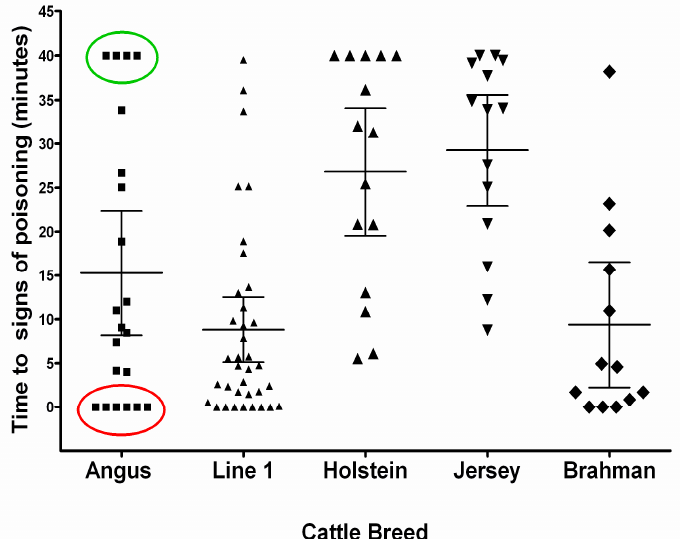
Figure 5. A comparison of different breeds of cattle to larkspur toxicosis. Data represent a scatter plot with the mean and 95% confidence interval for each breed. The data depict the cattle responses to a standardized dose of tall larkspur (8 mg/kg total toxic alkaloid) at 24 h after oral dosing. Line 1 represents Line 1 Herefords from Fort Keogh Livestock and Range Research Laboratory, Miles City, Montana. To determine the time to signs of poisoning, the cattle were exercised behind a tractor at 5–6 kph on a dirt track for 40 min or until they exhibited larkspur-induced muscle weakness. Examples of resistant ( green circle ) and susceptible ( red circle ) animals are depicted for Angus (From